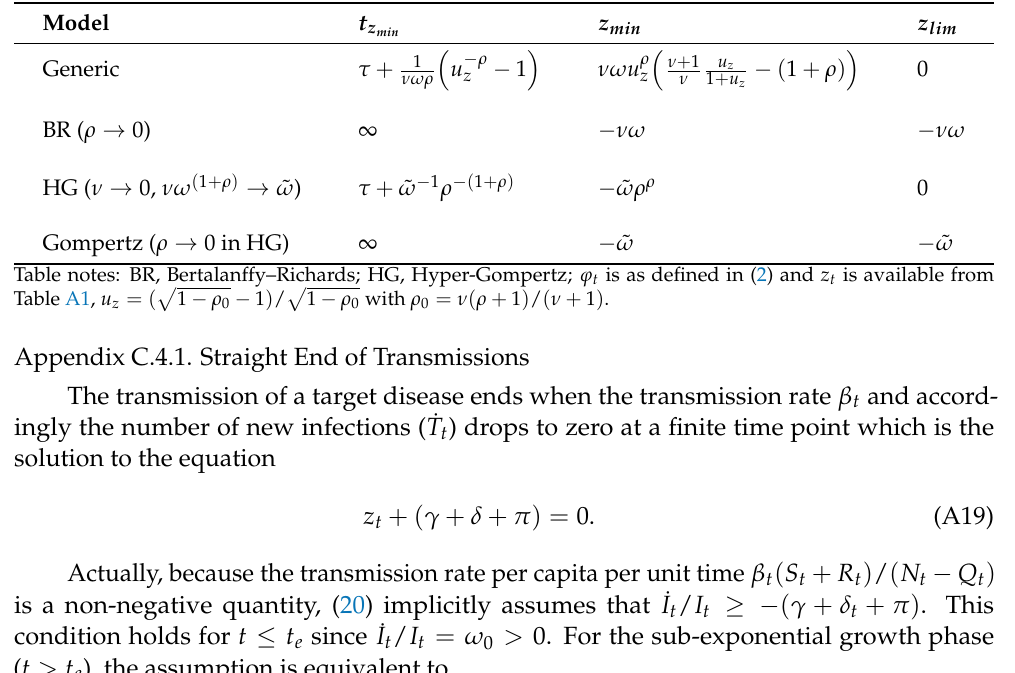
Table A3. Minimum point ( t z z t of the ratio z t = ¨ ϕ t / ˙ ϕ t of the growth acceleration ¨ ϕ t to the growth rate ˙ ϕ t of the generic lim t → ∞ growth curve ( ϕ t ) [8] and its limiting cases